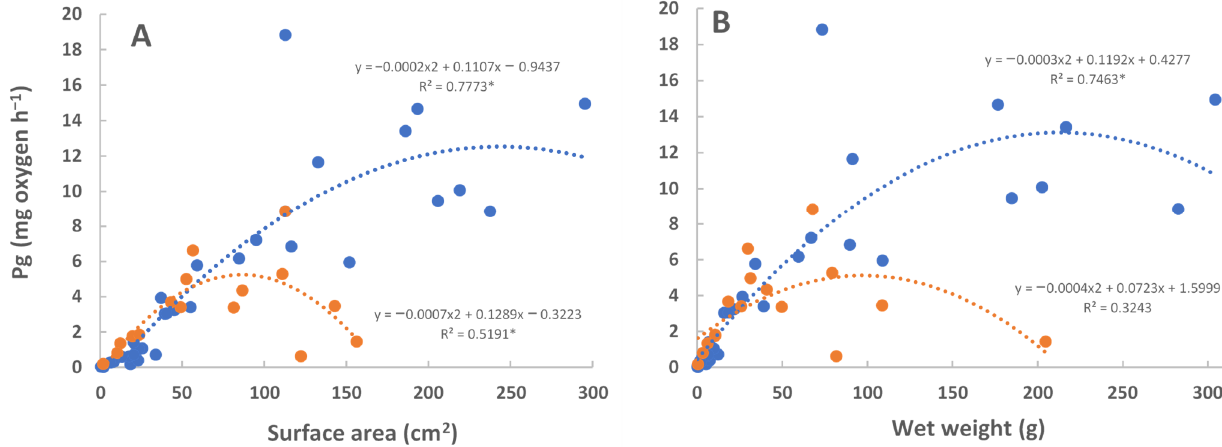
Figure 4. Gross photosynthesis (mg O 2 h − 1 ) of medusae of C. xamachana (red, n = 16) and C. frondosa (blue, n = 30) per ( A ) bell surface area (cm 2 ) and ( B ) wet weight (g). Regressions with * are significant ( p < 0.05).